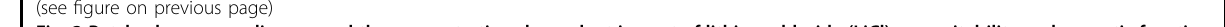
Fig. 3 Patch – clamp recordings reveal the concentration-dependent impact of lithium chloride (LiCl) on excitability and synaptic function of human cortical neurons. A Schematic representation of the applied protocol to evaluate the effect of therapeutic and overdose concentrations of LiCl on the hiPSC-derived neurons. B Examples of evoked fi ring responses to a 300 ms current injection of 45 pA into a current-clamped neuron at baseline, exposed to 1 mM, 5 mM LiCl, and after wash-out. C Examples of phase plane plots, calculated as the fi rst derivative of the membrane potential at the initial AP, in a train of at least two APs, against the membrane potential. The black line denotes the AP threshold (at 10 mV/ms). D Diagrams illustrate the membrane potential parameters in the different conditions with individual cells shown as scattered dots. n = 11 ( n = 8 for wash-out), N = 3. E , i Pie charts show the percentage of cells with spontaneous EPSCs and spontaneous IPSCs. A total number of cells is given in the center. E , ii Average frequency and amplitude of spontaneous EPSCs and IPSCs in the different conditions with individual cells shown as scattered dots. The relative frequency of the spontaneous events compared to baseline is also shown. E , iii The ratio of the average frequency of spontaneous AMPA/GABA, n = 10, N = 3. The experiments were done in a paired setup. The data are presented as mean ± standard deviation. One-way ANOVA with Dunnett ’ s correction (baseline compared to the indicated group) was applied to calculate the shown p values. For comparing the “ wash-out ” group, a paired t test was used for p value calculation. In the diagrams showing relative values, the p values were calculated by unpaired t